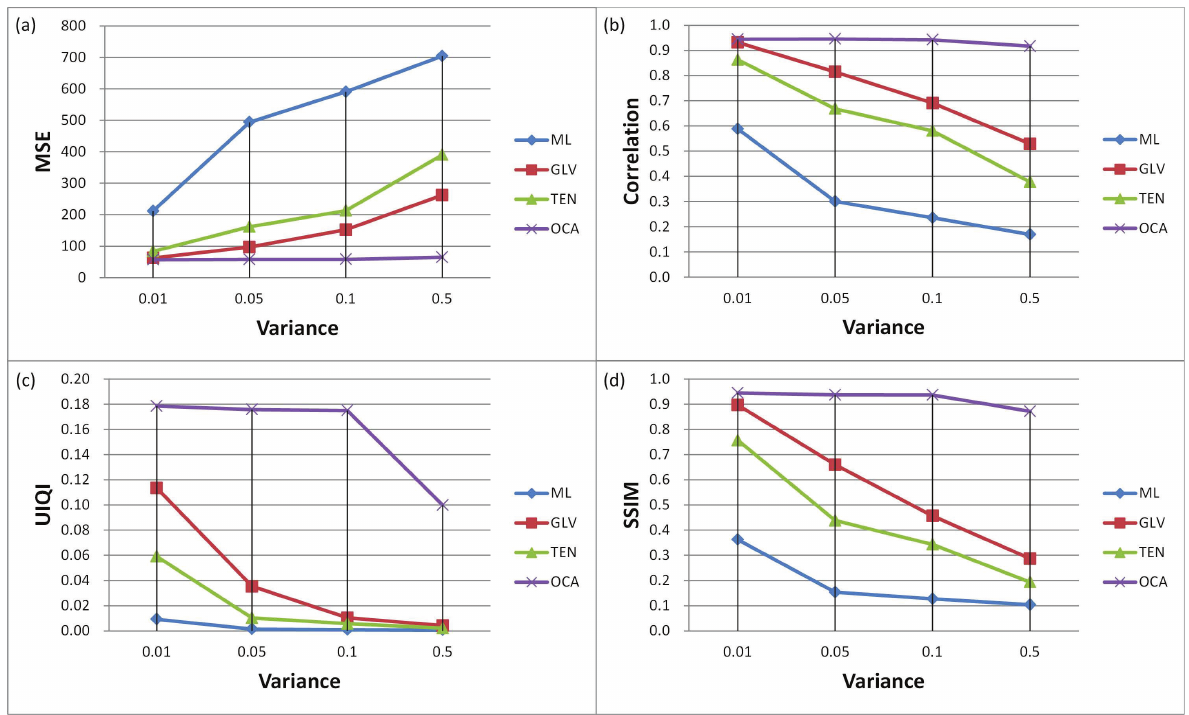
Figure 11. Comparison of SFF methods for various speckle noise variances.